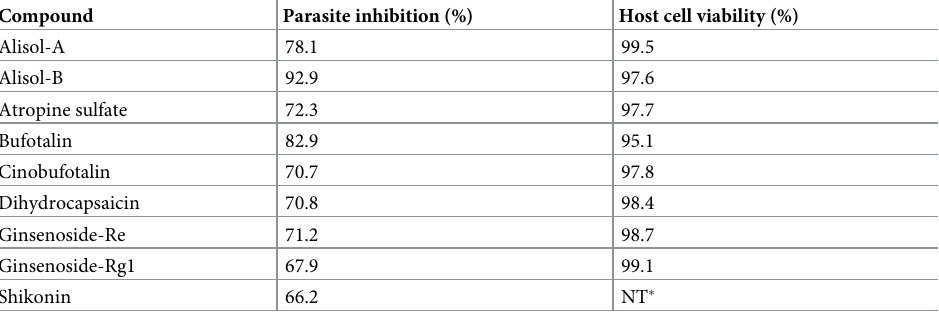
Table 1. The nine lead anti- C . parvum compounds identified in the first screen at a concentration of 1 μ M and tested against the C . parvum HNJ-1 strain. Compound Parasite inhibition (%) Host cell viability (%) Alisol-A 78.1 99.5 Alisol-B 92.9 97.6 Atropine sulfate 72.3 97.7 Bufotalin 82.9 95.1 Cinobufotalin 70.7 97.8 Dihydrocapsaicin 70.8 98.4 Ginsenoside-Re 71.2 98.7 Ginsenoside-Rg1 67.9 99.1 Shikonin 66.2 NT � � NT = Not tested Parasite growth inhibition values with C . parvum; host cell viability values with HCT-8 cells.